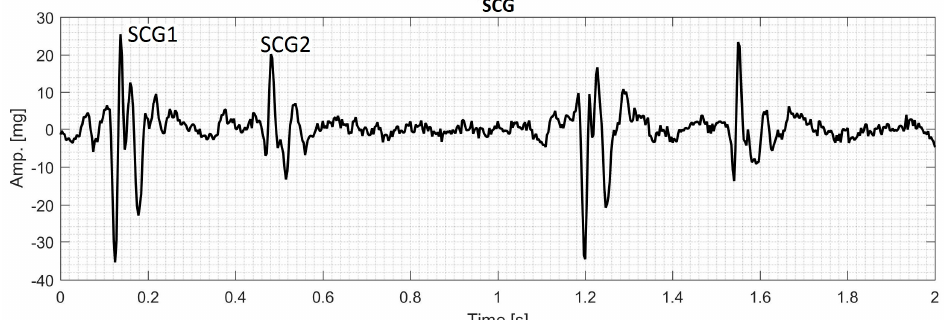
Figure 1. Measured seismocardiographic (SCG) signal showing two cardiac cycles. There are two SCG events (SCG1 and SCG2) for each cycle. These are labeled for the first cycle.